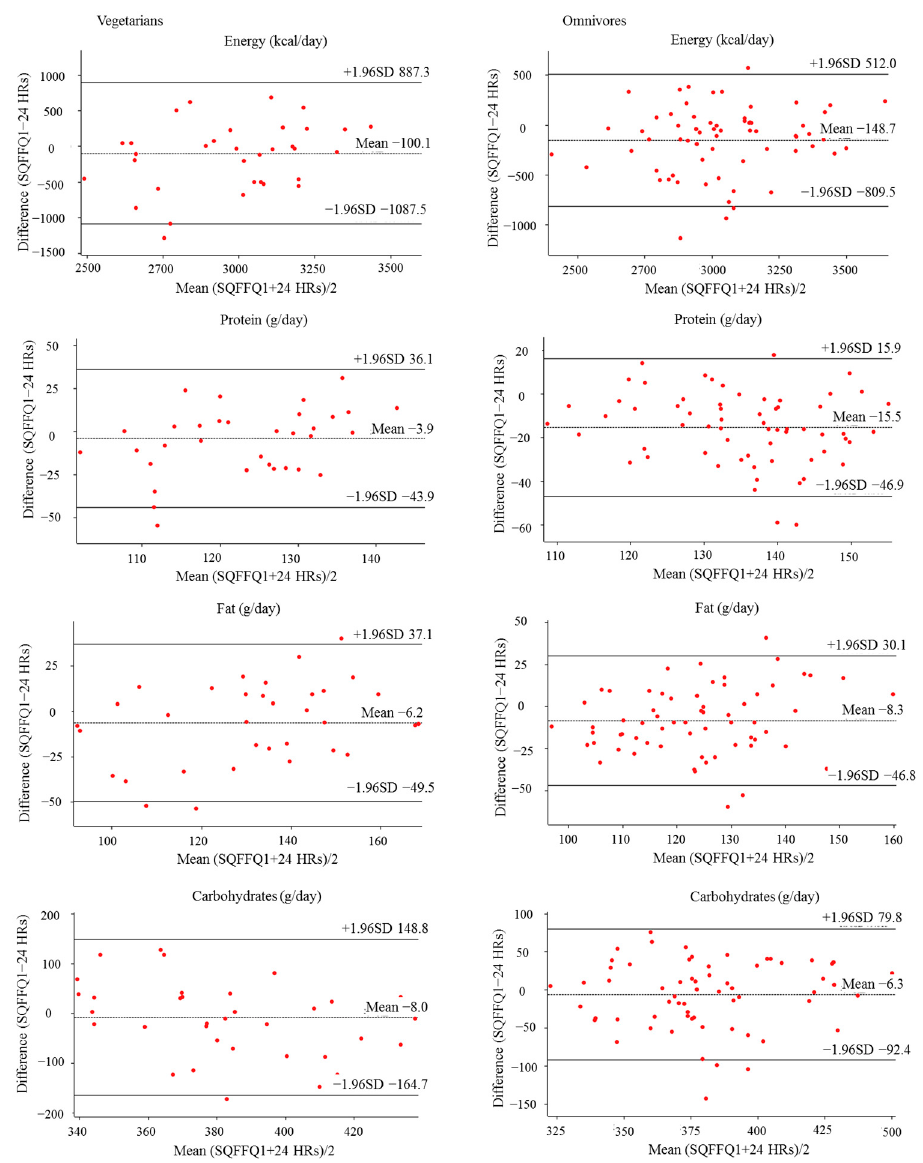
Figure 2. Bland–Altman plot represents the agreement between the SQFFQ1 and 24 HRs for energy and macronutrients. The dashed line represents the average difference between the two methods, while the solid line represents the distance between the mean of the difference ± 1.96 times standard deviations.